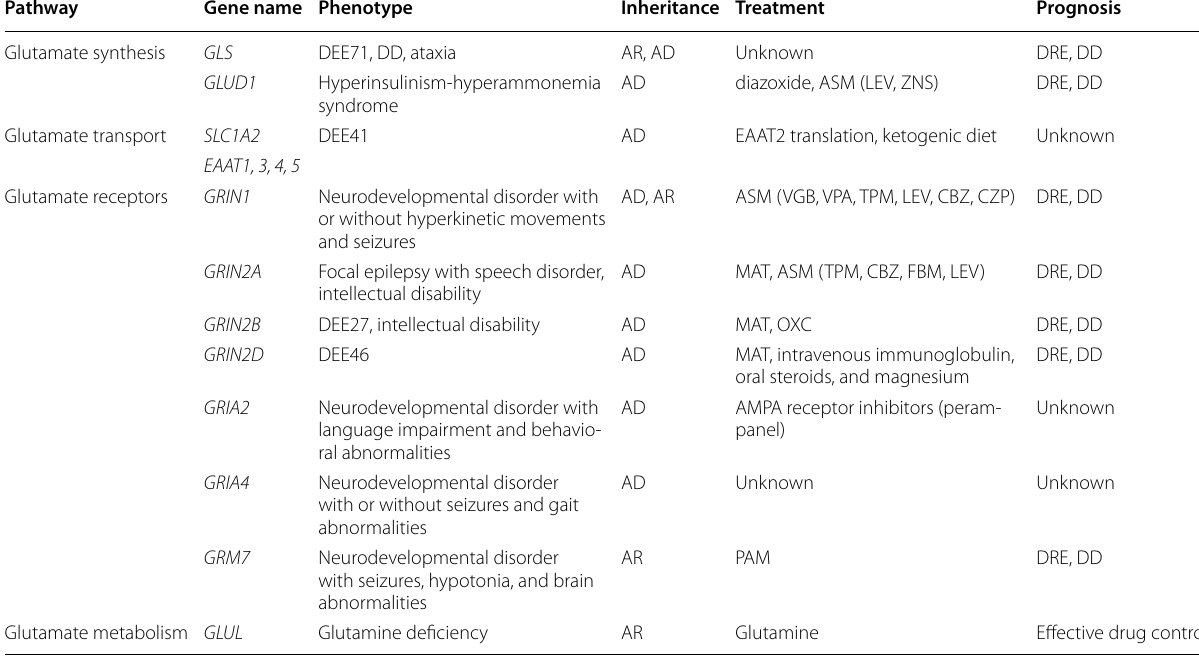
Table 1 Genetic variations in the pathway of glutamate metabolism and related